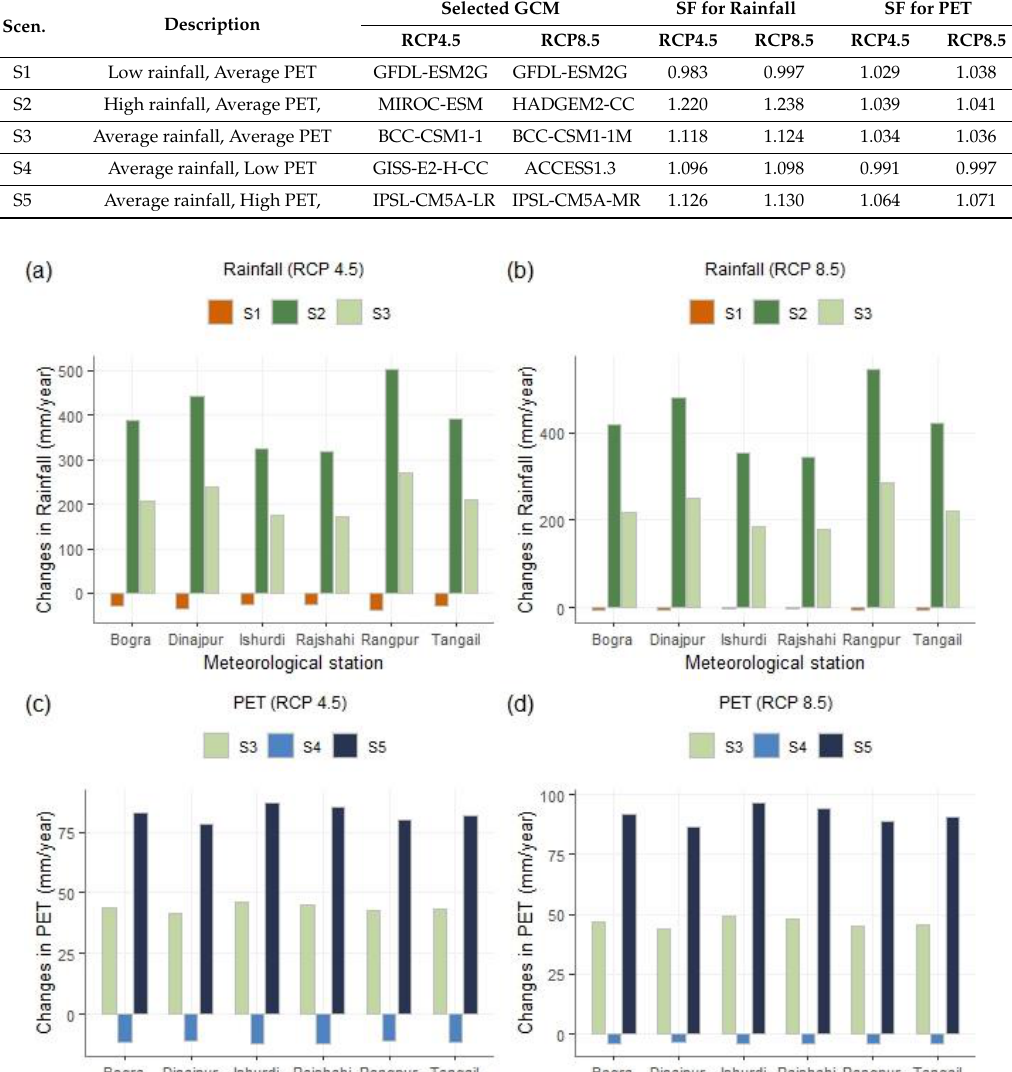
Table 4. Best performing GCMs and scaling factors (SFs) for the northwest region of Bangladesh. Scen.